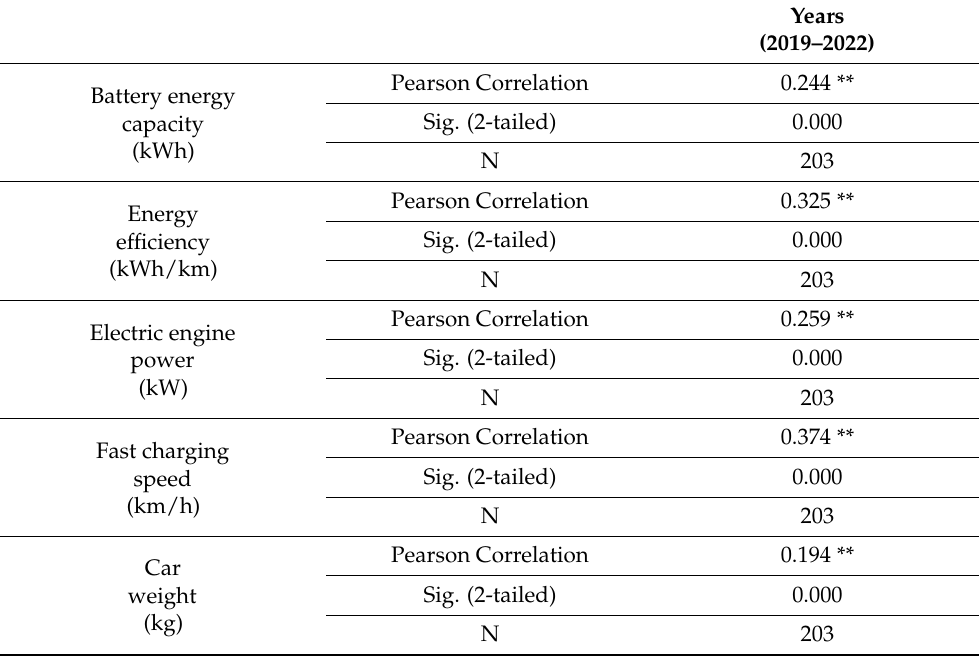
Table 7. Correlation coefficients between the technical parameters and the year of